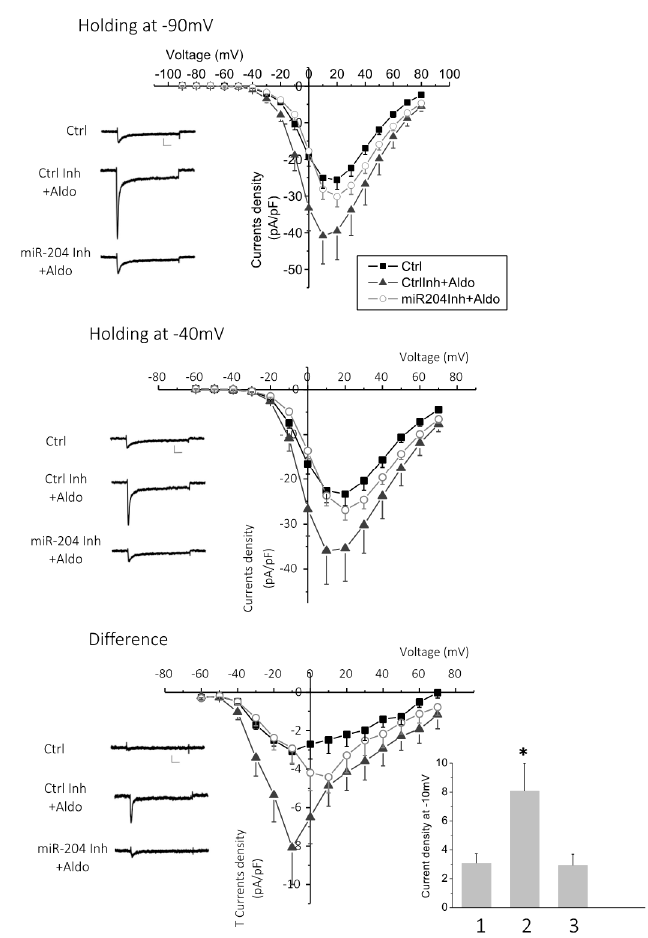
Figure 6. Inhibition of miR-204 expression prevents an aldosterone-induced increase of Ca 2+ currents. Calcium currents were recorded in the whole cell configuration of the patch clamp technique in cardiomyocytes transfected (37.5 nM for 24 h) either with the antagomir targeting miR-204 (miR204Inh + Aldo) or with luciferase siRNA (Ctrl Inh + Aldo) and stimulated for 24 h with aldosterone (1 µ M). Control cells (Ctrl) were naive (non-transfected) and resting (unstimulated) cardiomyocytes. The graphs show the current density–voltage relationship recorded from a holding potential at − 90 mV (upper panel), reflecting the total (L-type and T-type) calcium current, or at − 40 mV (middle panel), reflecting the L-type current. The difference plots that specifically reflect T-type Ca 2+ currents are shown in the lower panel. The traces shown on the left are representative examples of recordings at − 10 mV depolarization steps. Data are means + SEMs from 15 (Ctrl) or 12 (Ctrl Inh or miR204Ihn) independent cells. The bar graph represents the means and SEMs of T current density recorded at − 10 mV in control cells ( 1 ), control inhibitor plus aldosterone ( 2 ), and antagomir targeting miR-204 plus aldosterone ( 3 ) (* p < 0.05).